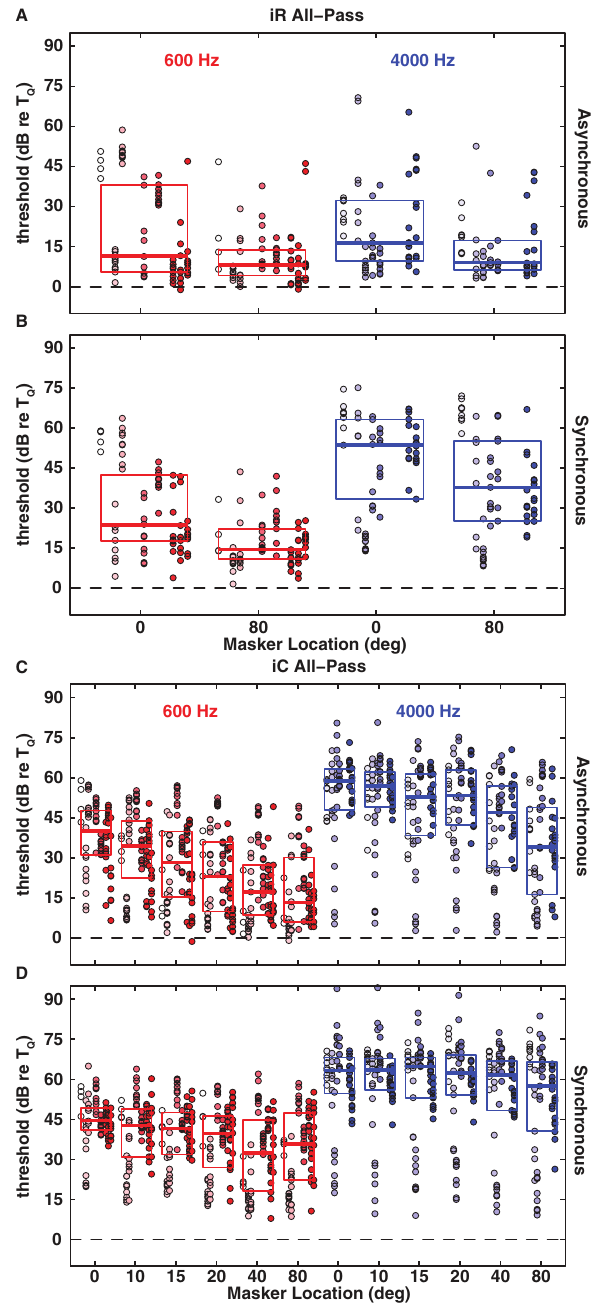
Figure 3. Signal detection thresholds re T Q in the presence of random frequency (iR: A, B) and constant frequency (iC: C, D) all-pass informational maskers as a function of masker location for the the 600-Hz (red) and the 4000-Hz (blue) signals in the asynchronous (A, C) and synchronous (B, D) timing conditions. All other conventions as in Fig. 1. Note that we tested more spatial configurations for the iC masker.